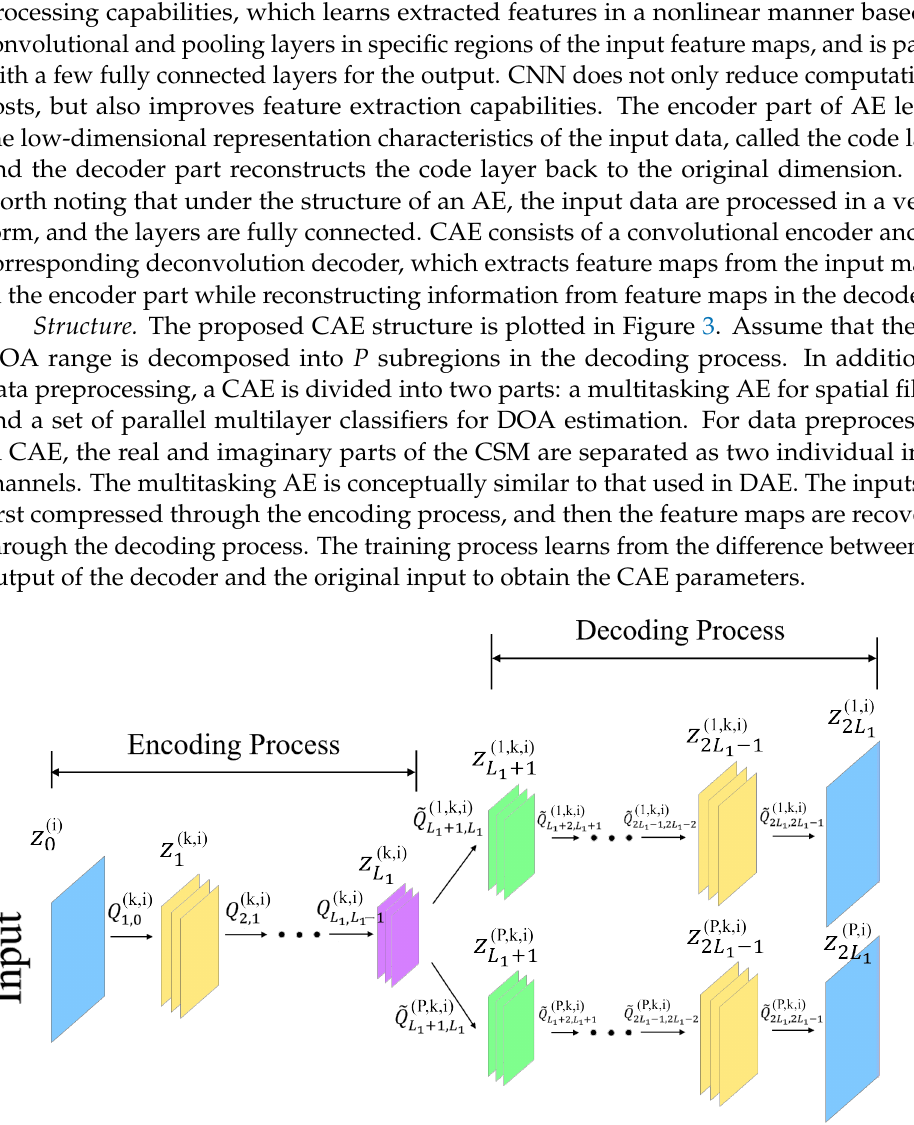
Figure 3. The proposed convolutional autoencoder structure for DOA